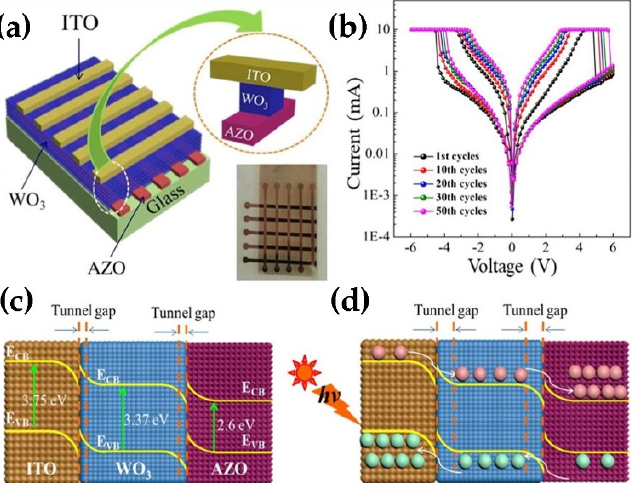
Figure 19. ( a ) Structure diagram of ITO/WO 3 /AZO device. ( b ) The sample was annealed at 600 °C and then irradiated for 30 min, followed by 50 consecutive cycles of volt − ampere characteristic curve in logarithmic form. ( c ) Energy band structure of ITO/WO 3 /AZO. ( d ) Schematic diagram of carrier migration and interfacial tunnel gap formation under light irradiation. Reproduced or adapted from [104].